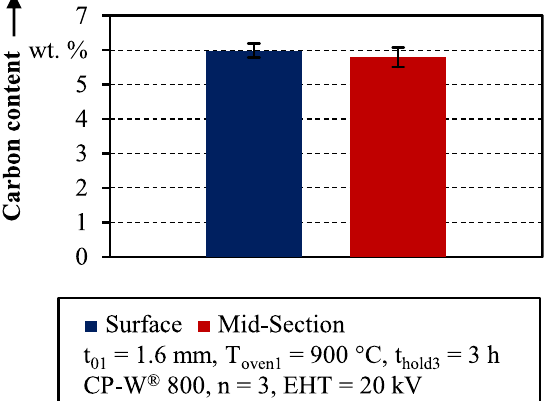
Fig. 8. Micrograph of carburized samples.